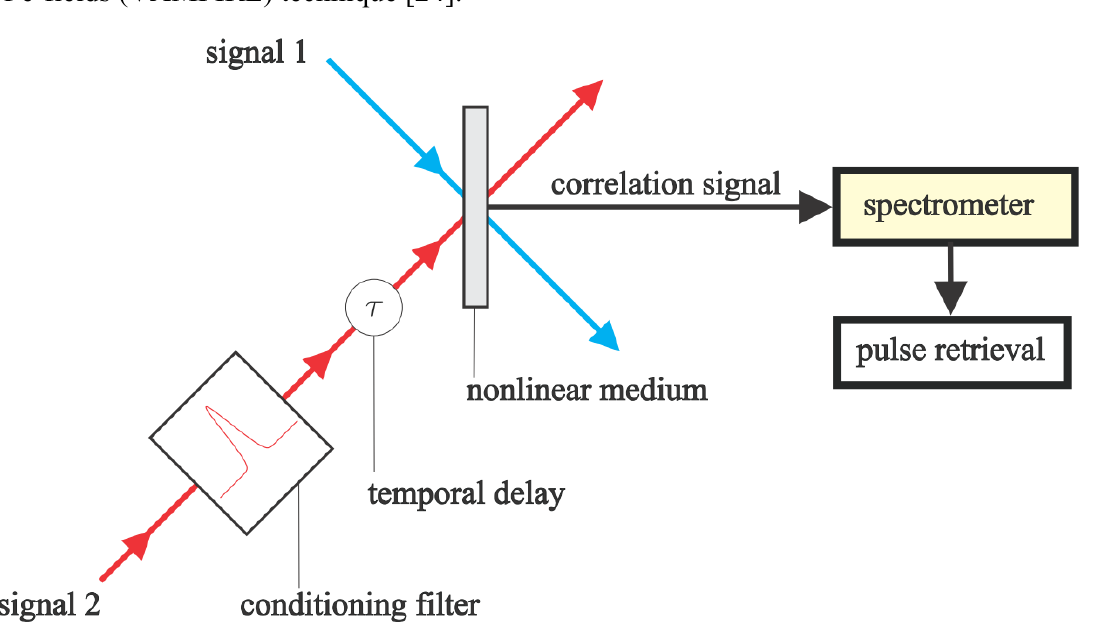
Figure 5. Optical schematic of the very advanced method for phase and intensity retrieval of e-fields (VAMPIRE) technique